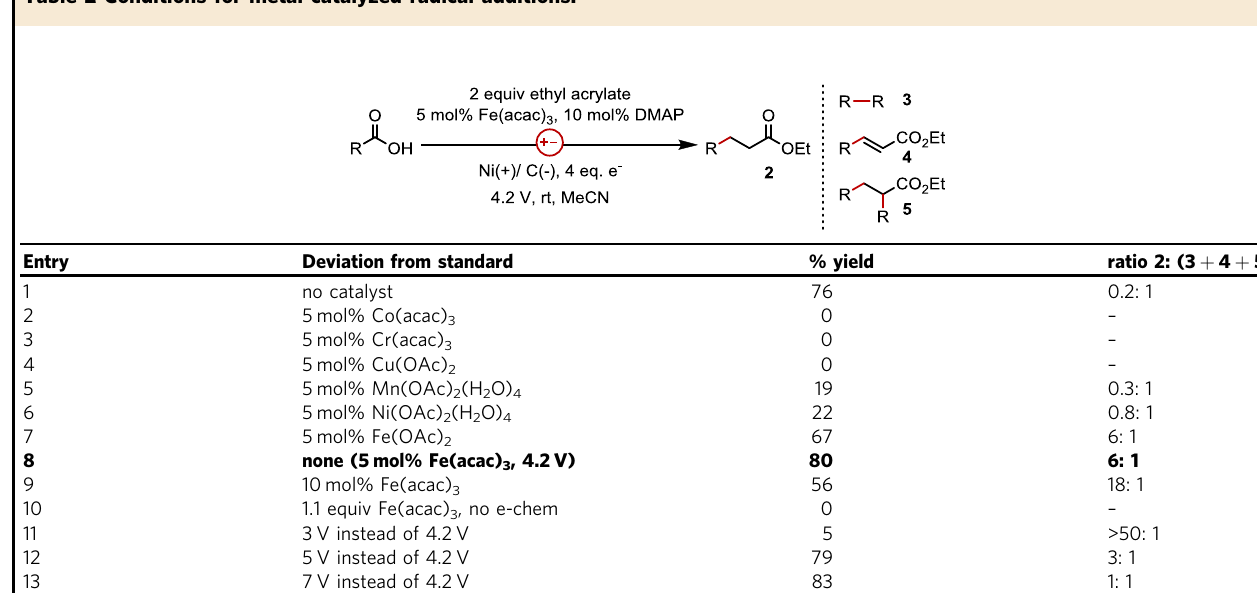
Table 2 Conditions for metal-catalyzed radical